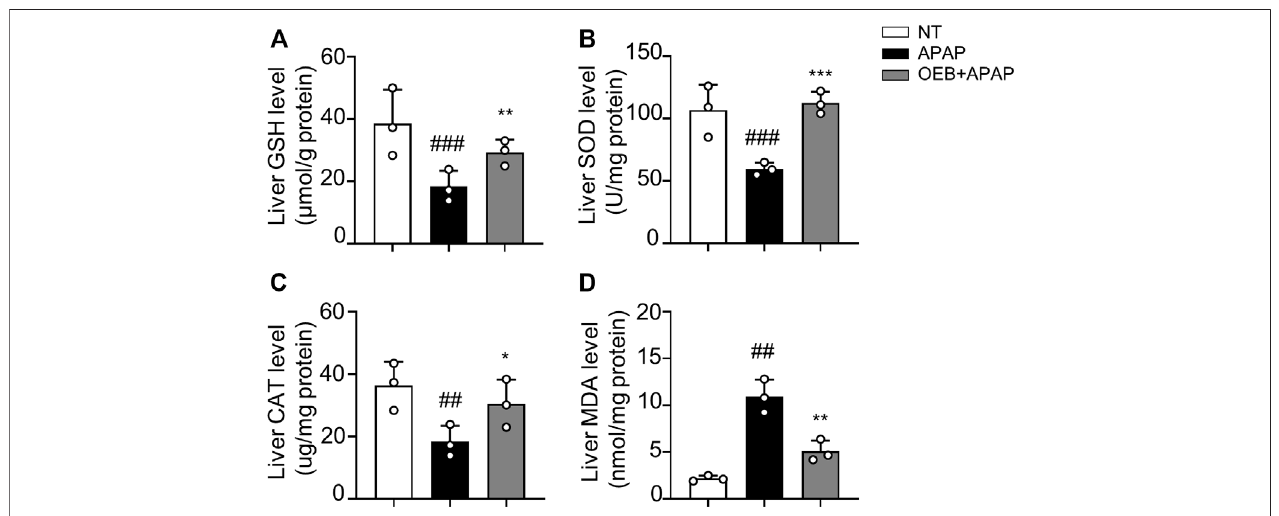
FIGURE 4 | OEB reduced APAP-induced hepatotoxicity via regulating oxidative enzyme activities. (A) Glutathione (GSH), (B) superoxide dismutase (SOD), (C) catalase (CAT) and (D) malondialdehyde (MDA) levels in the liver tissue were measured. ( n = 3). Data are representative of three independent experiments with similar results. * p < 0.05, **p < 0.01, *** p < 0.001 versus APAP-treated group. ## p < 0.01, ### p < 0.001 versus NT